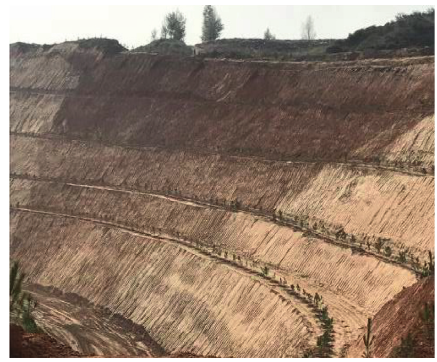
Figure 2: Slope body in the comprehensive coal control area of 3-1 coal seam. Table 1: The material ratio of the